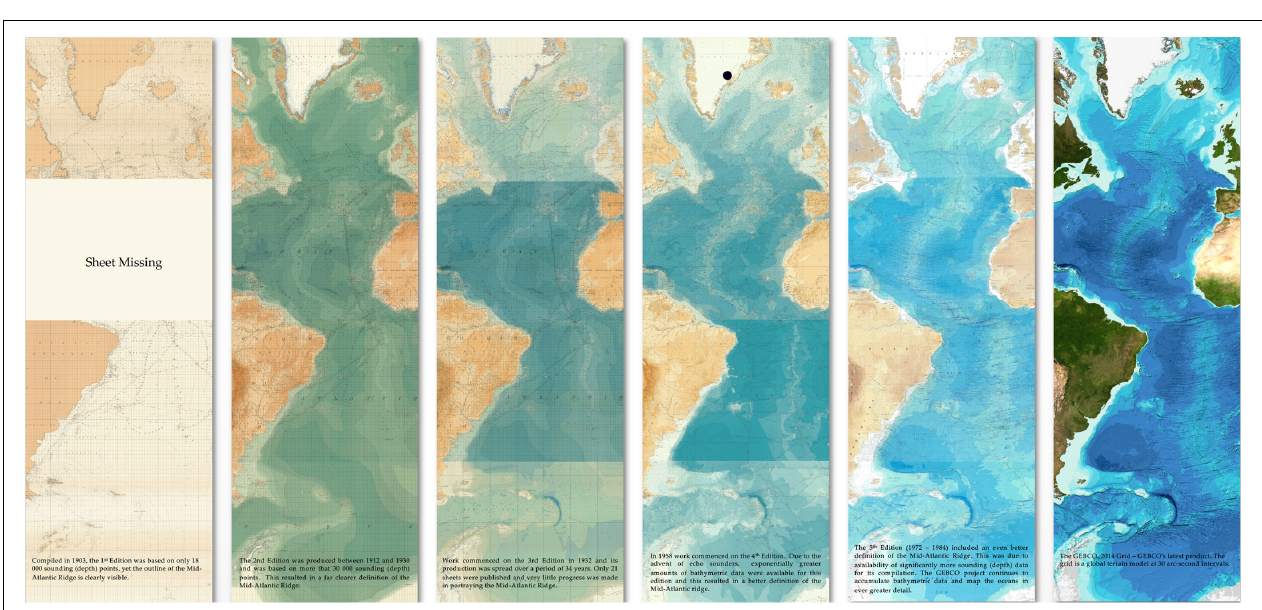
FIGURE 6 | The Mid-Atlantic Ridge as Portrayed in GEBCO charts since 1903 (courtesy of Anthony Pharaoh, IHO).